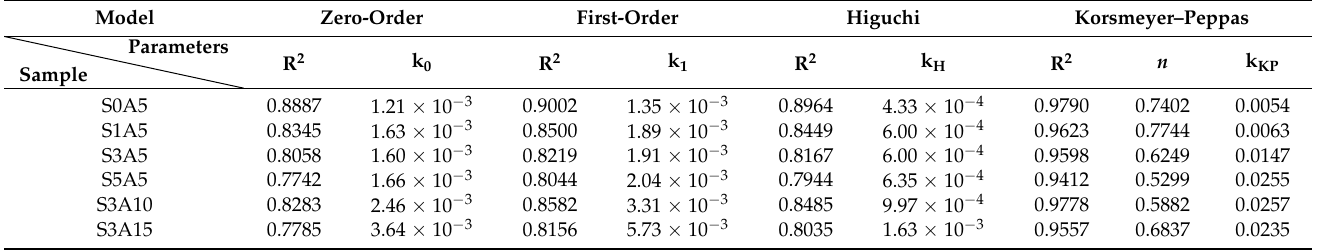
Table 3. Fitting parameters of drug release kinetics of ASA from the dual drug-loaded biomimetic composite scaffolds.